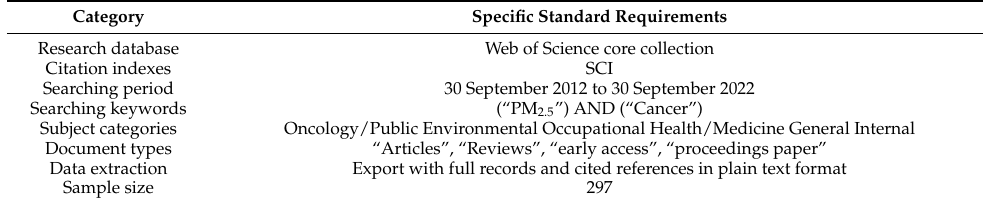
Table 1. Data source and search